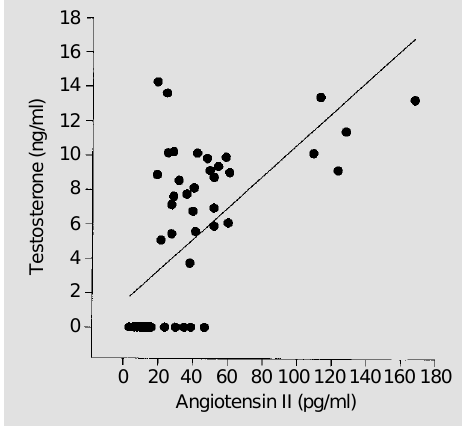
Figure 3 - Pearson’s correlation of plasma testosterone (ng/ml) versus angiotensin II levels (pg/ ml) in SHR males (20 weeks) (r = 0.57,